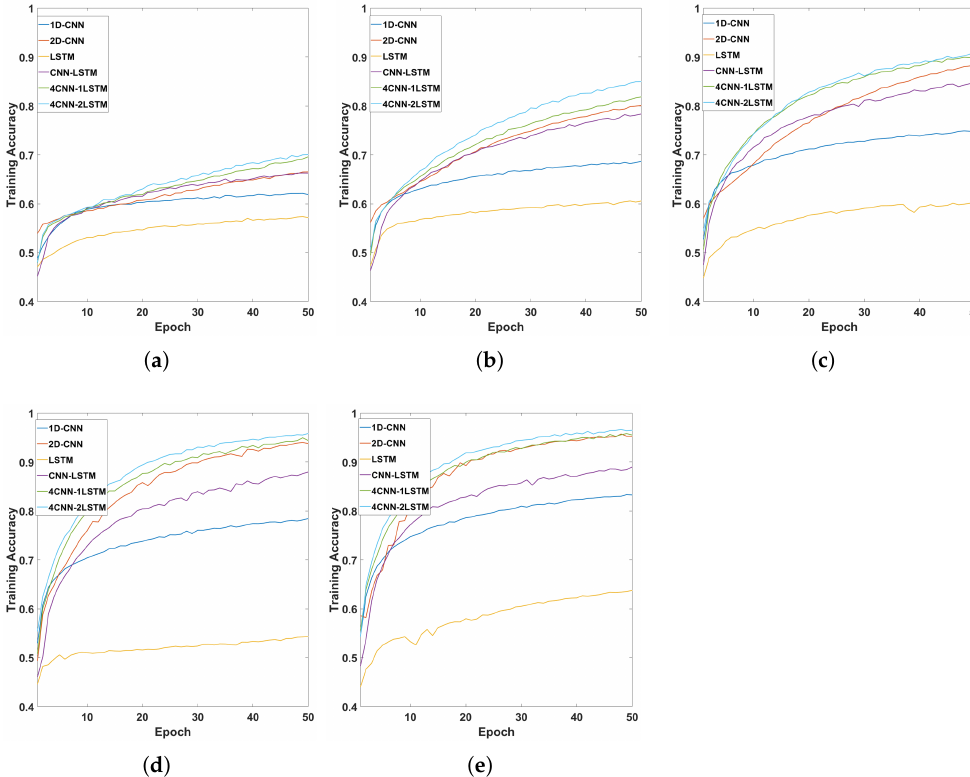
Figure 13. Training accuracy input length: ( a ) Timeseries 1 s. ( b ) Timeseries 2 s. ( c ) Timeseries 3 s. ( d ) Timeseries 4 s. ( e ) Timeseries 5 s. Table 5. Validation confusion matrix at 5 s timeseries